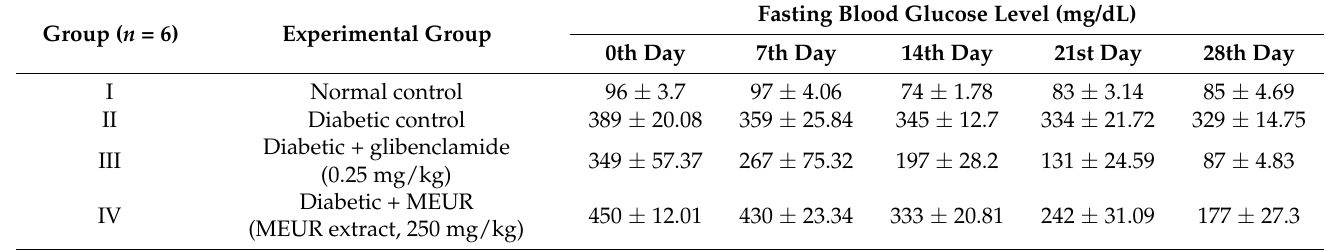
Table 1. Effect of MEUR on fasting blood glucose level. The effect of MEUR on fasting blood glucose levels of STZ-induced diabetic rats. Glibenclamide served as a positive control. Each value is expressed as mean ± S.E.M. ( n =